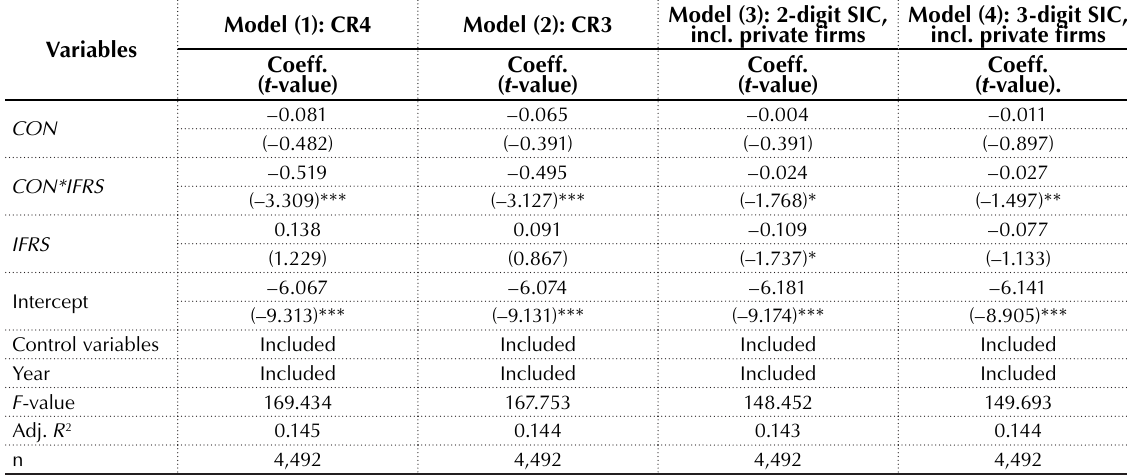
Table 5. Robustness tests for hypothesis 1: re-measurement of industry